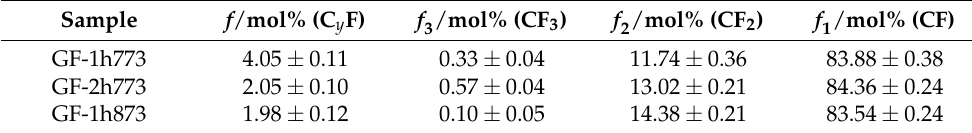
Table 1. Quantitative analysis of 19 F MAS centerband NMR spectra.